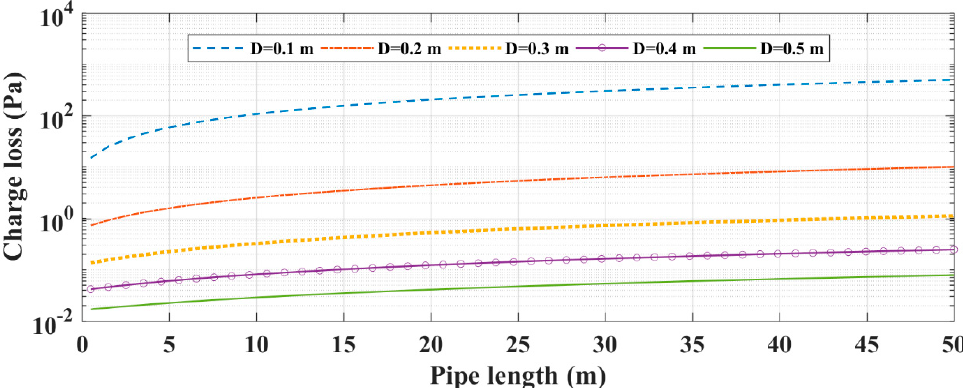
Figure 7. Charge loss of the EAHE system as a function of pipes length and diameter.